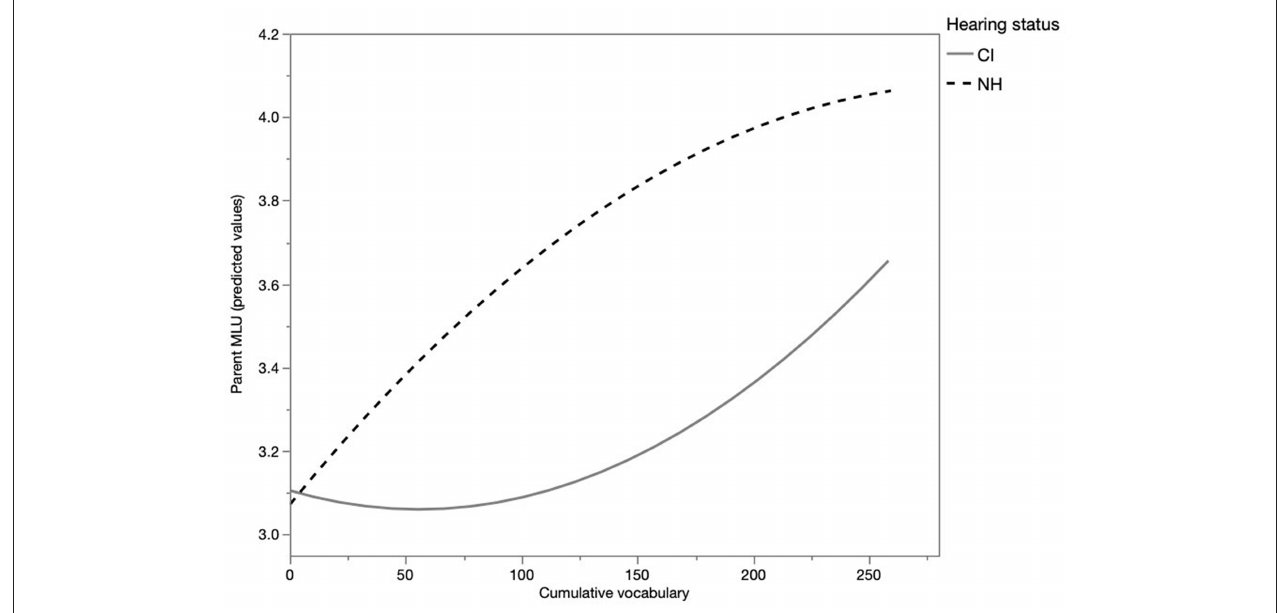
FIGURE 2 | Development of global parent MLU for CI and NH children (predicted values).